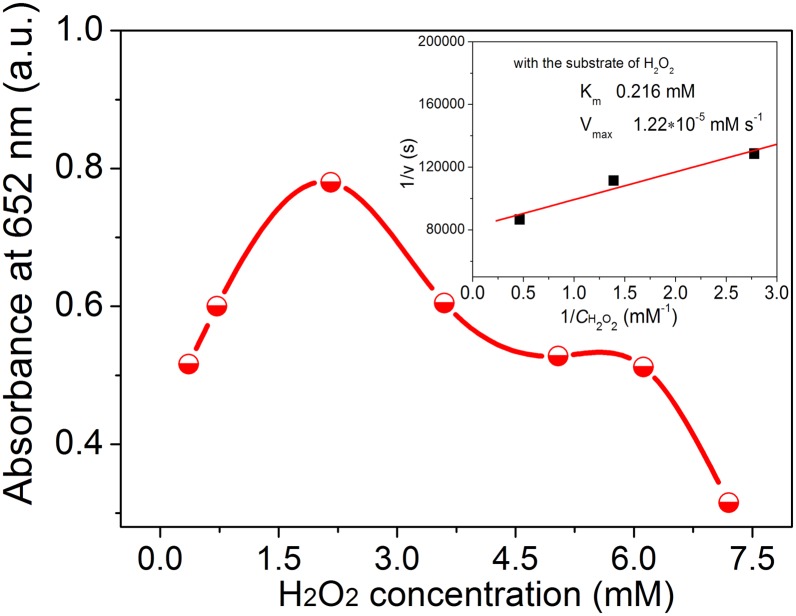
H2O2 concentration dependent peroxidase-like catalytic activity of Ag3PO4 nanocrystals.Reaction conditions: 0.3 mM of TMB, 2 mg/mL of Ag3PO4 in 5 mL of NaAc buffer with pH 4.0. The concentration of H2O2 varies in the range of 0.36–7.2 mM. The reaction proceeded at 25°C with time of 30 min.